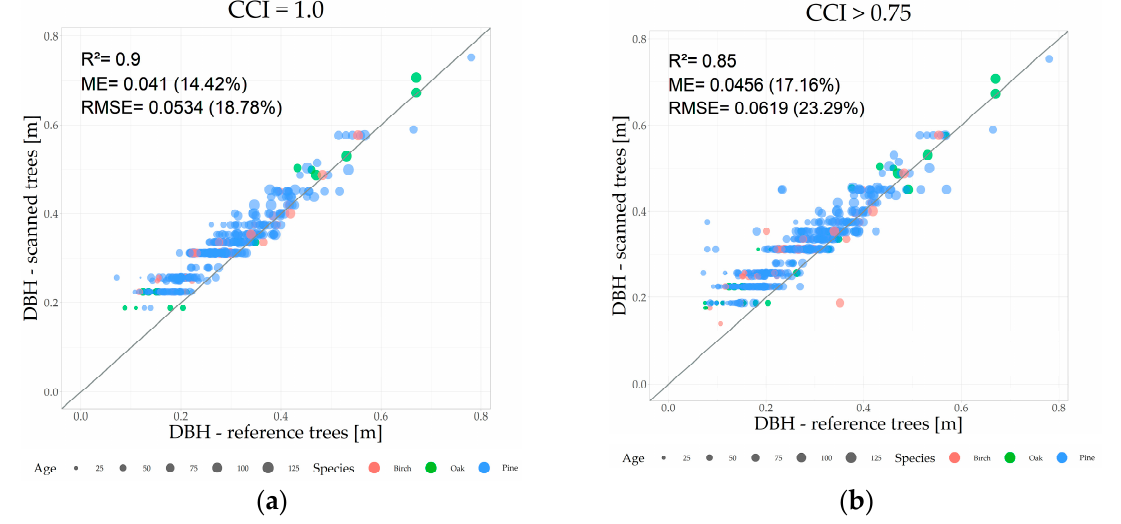
Figure 7. Correlation between DBH extracted from the iPad scans and the reference DBH, including